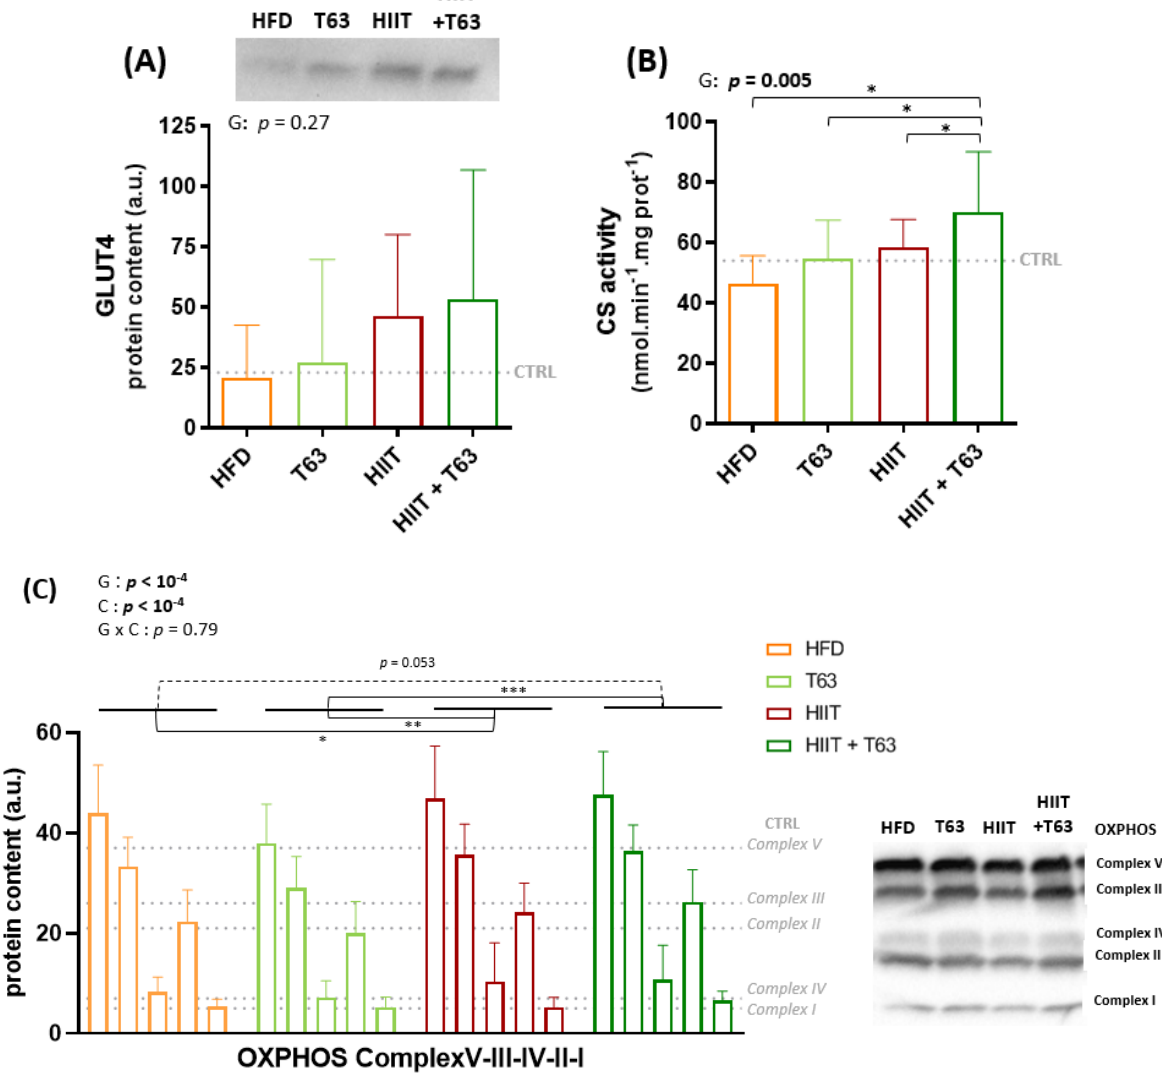
Figure 5. Effects of T63 supplementation and/or HIIT on GLUT4 protein content ( A ), citrate synthase (CS) activity ( B ), and OXPHOS complex protein content ( C ) in soleus. * p < 0.05, ** p < 0.005, *** p < 0.0005, G: group effect, T: time effect, G × T: group × time effect.